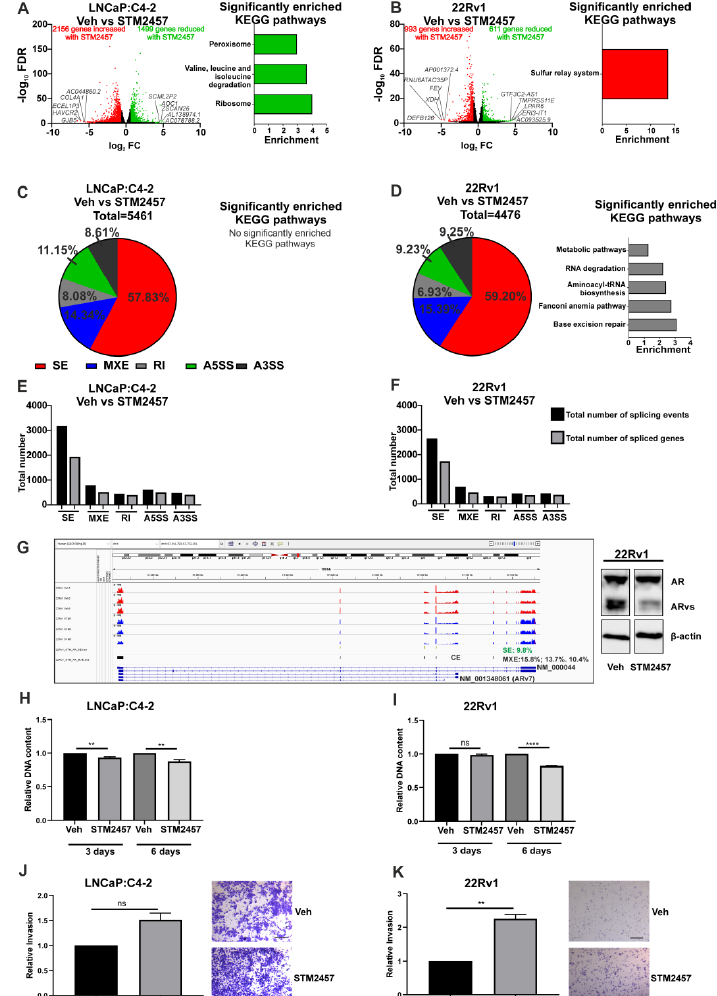
Figure 3. Pharmacological inhibition of METTL3 by STM2457 regulates transcriptional and alternative splicing programmes and cellular phenotype in PCa cell lines. PCa cells treated with STM2457 (10 µ M) were analysed by RNA-seq and the DEGs and DSGs determined. The METTL3-regulated differential gene expression and significantly enriched KEGG pathways in LNCaP:C4-2 ( A ) and 22Rv1 ( B ) are shown. Genes with significantly higher expression following METTL3 inhibition are red and genes with significantly lower expression following METTL3 inhibition are green. Non-significantly differentially expressed genes are plotted in black. METTL3-regulated differential splicing events in LNCaP:C4-2 ( C ) and 22Rv1 ( D ) are shown. The total number of significant splicing events and genes in LNCaP:C4-2 ( E ) and 22Rv1 ( F ) are shown. Normalised expression coverage for vehicle (red) and STM2457 (blue) treated 22Rv1 cells is presented using the Integrated Genome Viewer ( G ) [48]. The effect of the STM2457 METTL3 inhibitor on AR transcript expression was examined using the rMATs tool. Significant (FDR < 0.05) alterations of differential splicing, both mutual exclusive exon (indicated with black bars, 15.8, 13.7% and 10.4% dPSI) and skipped exon splicing events (9.8% dPSI, green bars), including affecting the cryptic exon (CE) associated with AR-v7 (NM_001348061) was observed. Treatment of 22Rv1 with STM2457 results in a decrease in the protein expression of AR variants (ARvs) ( G ). The effect of METTL3 inhibition on proliferation ( H , I ) and in vitro invasion ( J , K ) was also assessed. The scale bar represents 200 µ m. Significant gene expression: FC ± 1.5 and FDR < 0.05. Significant splicing events: dPSI ≥ 5% and FDR < 0.05. Veh = vehicle, FC = fold-change, FDR = false discovery rate. SE = skipped exon, MXE = mutually exclusive exon, RI = retained intron, A5SS = alternative 5 (cid:48) splice site, A3SS = alternative 3 (cid:48) splice site. ** p ≤ 0.005, **** p ≤ 0.0001. Molecular weights for proteins are indicated in the full annotated Western blot images (Figure